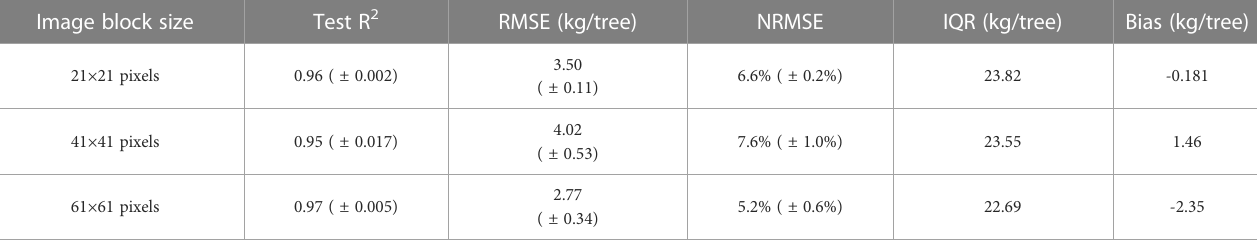
TABLE 1 Performance of CNN models with different image block sizes of the input aerial image clipped around each individual tree crown center. Image block size